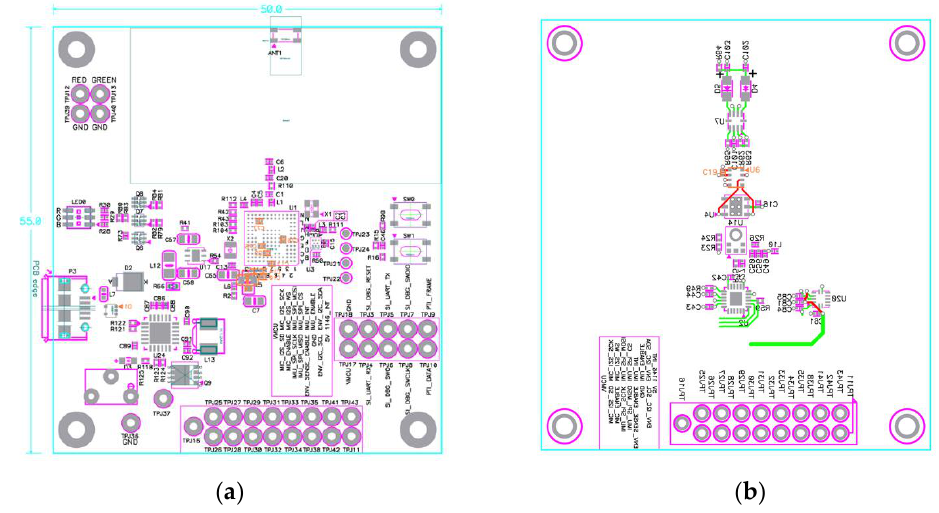
Figure 5. PCB artwork design of the proposed smart stethoscope: ( a ) main part; ( b ) sensor part.